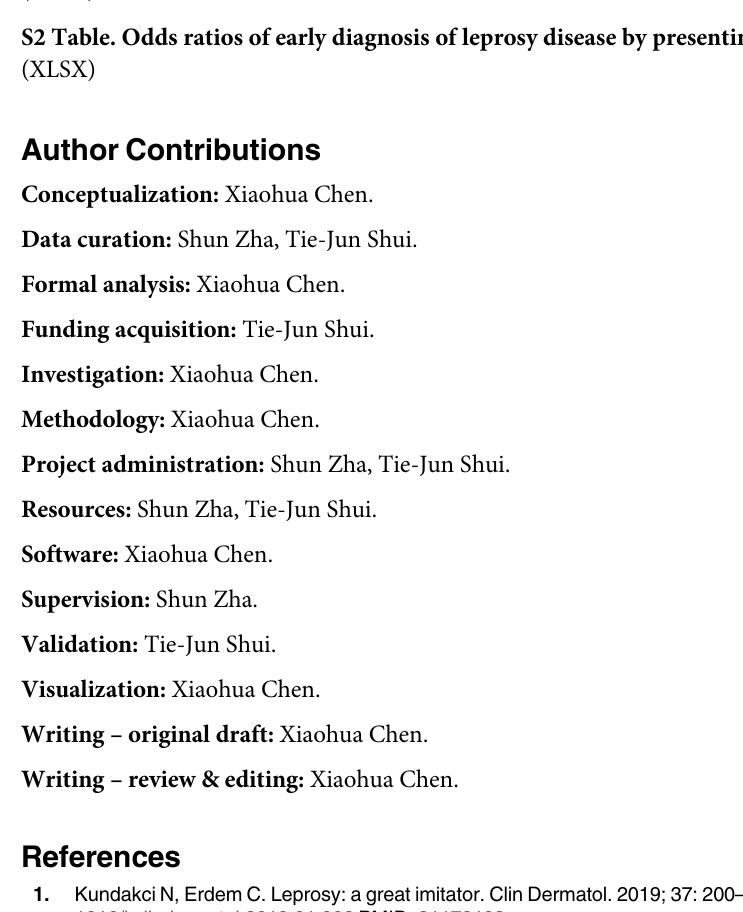
S1 Table. Odds ratios of MB of leprosy disease by presenting symptoms. S2 Table. Odds ratios of early diagnosis of leprosy disease by presenting